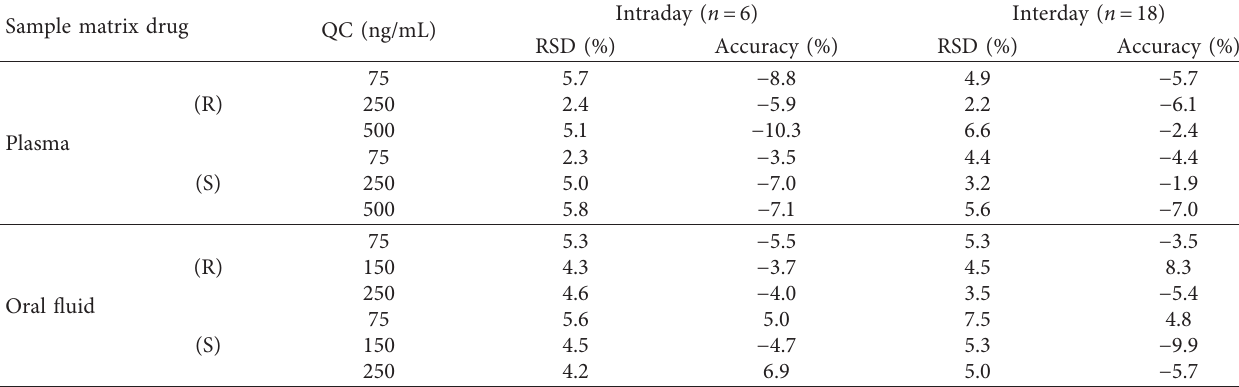
Table 1: Accuracy and precision of QC samples in human plasma and oral fluid. Sample matrix